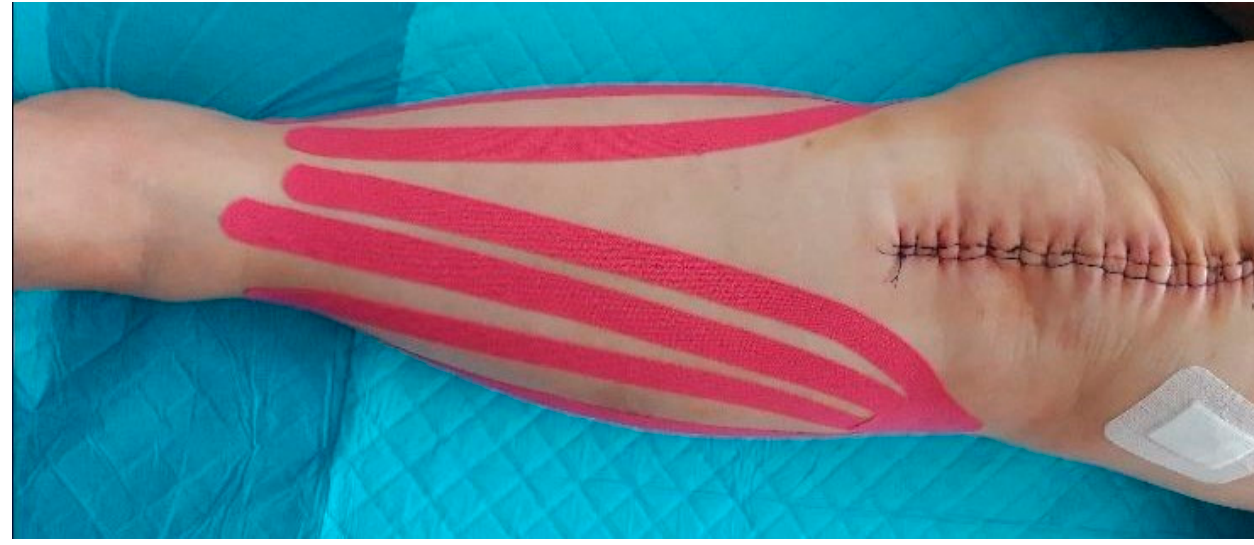
Figure 3. KT application (calf–anterior view).